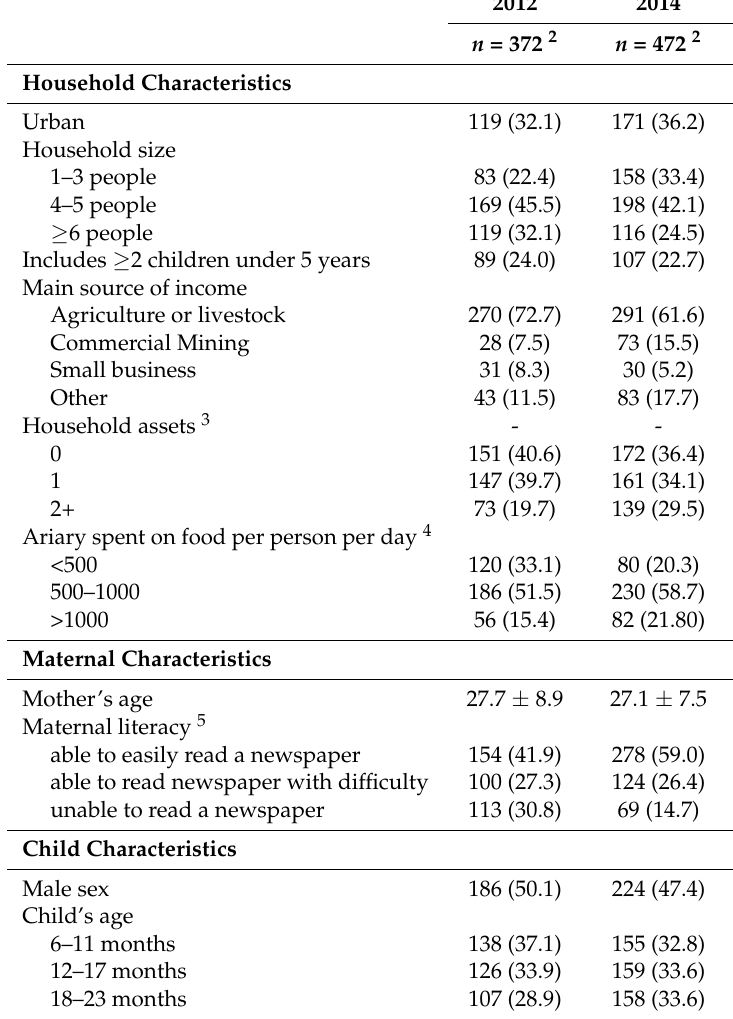
Table 1. Sociodemographic Characteristics of Study Sample 1